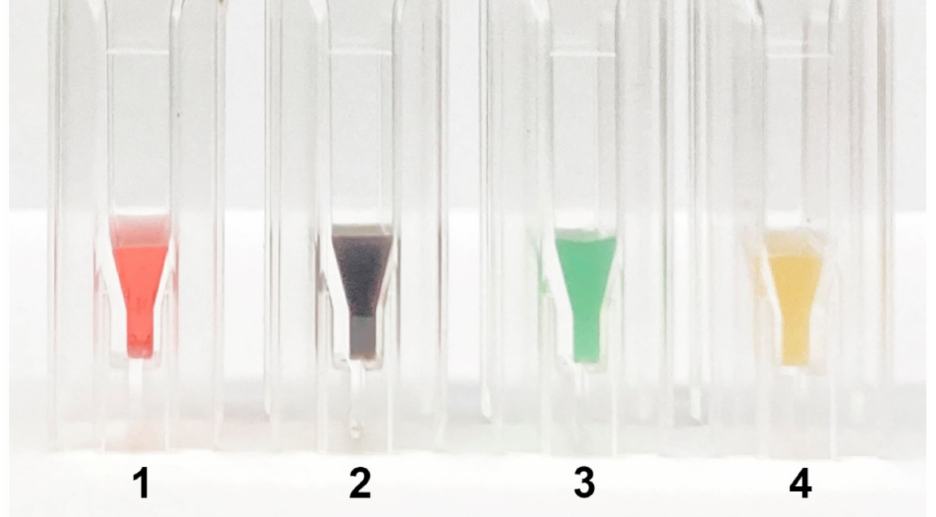
Figure 4. View of synthesized conjugates of pAbs with different nanoparticles: Au NPs (1), Au@Pt NPs (2), LPs (3), MPs